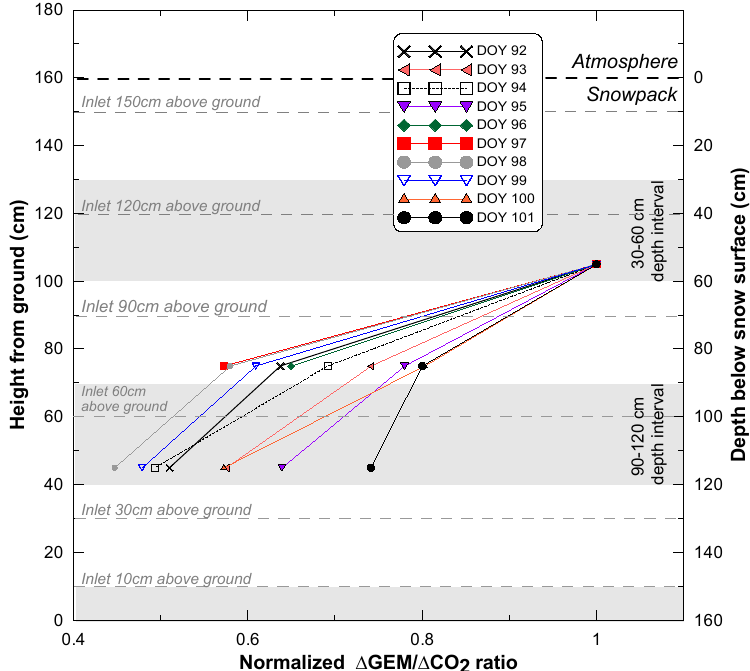
Fig. 6. Evolution with depth of daily 1 GEM/ 1 CO 2 ratio calculated over three inlet intervals: 120–90cm above ground (i.e, representative of 30–60cm layer below snow surface), 90–60cm above ground (i.e, representative of 60–90cm layer below snow surface), 60–30cm above ground (i.e, representative of 90–120cm layer below snow surface) for 10 days (labeled by day of year (DOY)). All ratio values have been normalized to the ratio observed in the top 30–60cm layer below the snow surface. Data were collected in